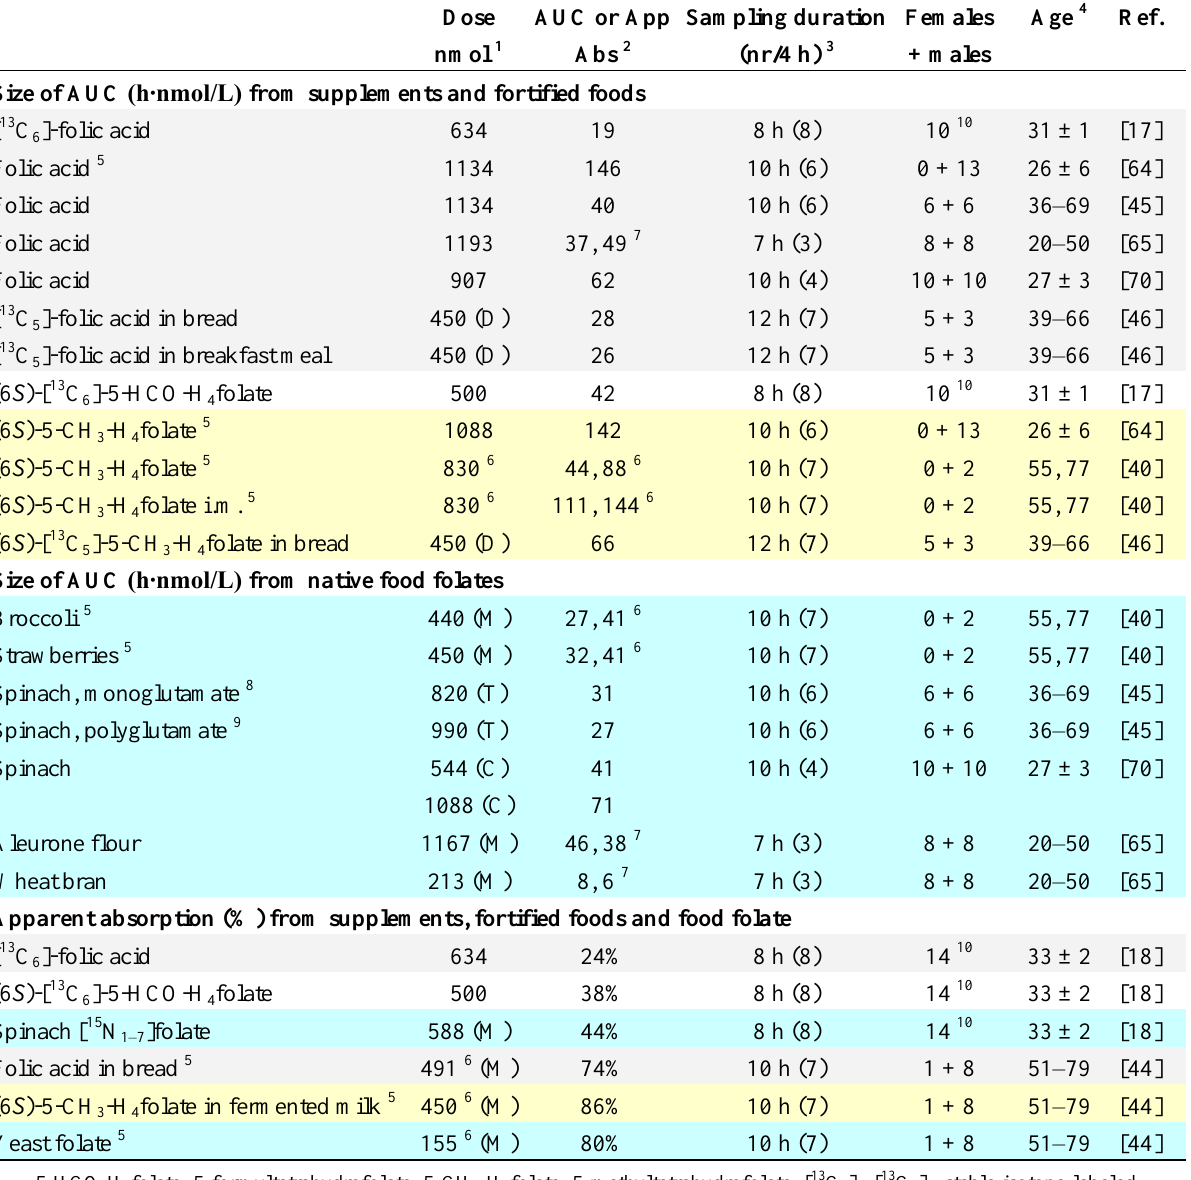
Table 3. Trials using plasma concentration to assess the bioavailability of food folates or fortificants.